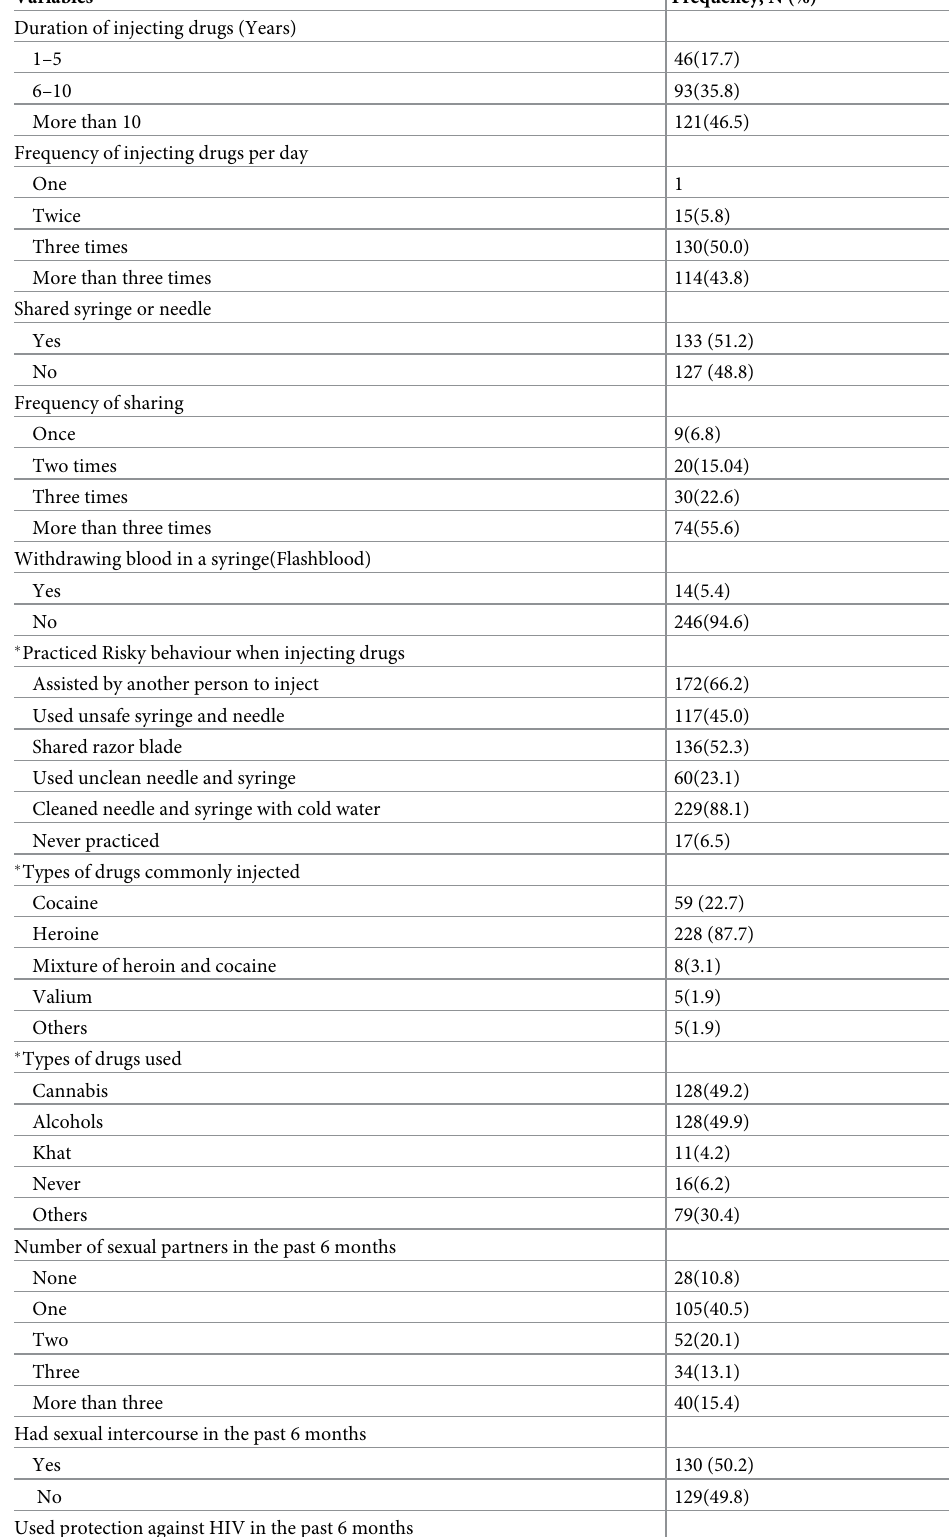
Table 2. Injecting drugs, risky sexual behaviour, and practices (N =